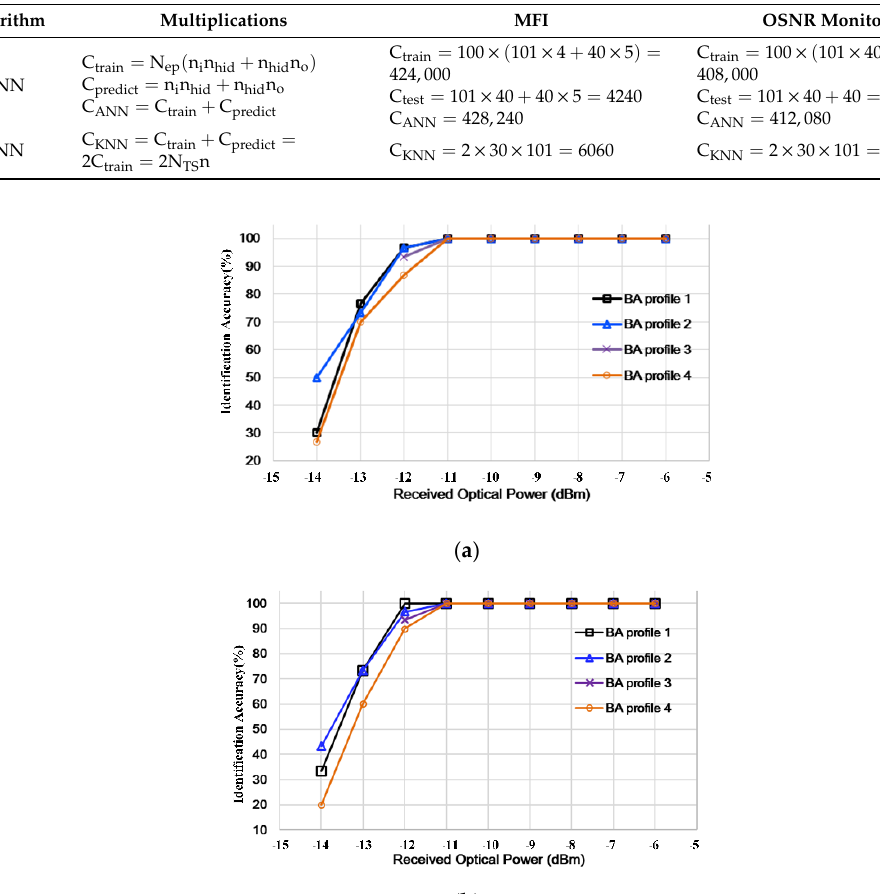
Table 2. The complexity comparison between KNN and ANN.